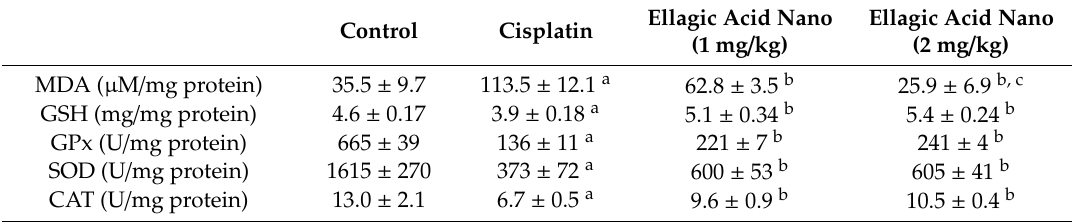
Table 2. Impact of ellagic acid nanoformulation on kidney antioxidants measured in cisplatin-treated rats.